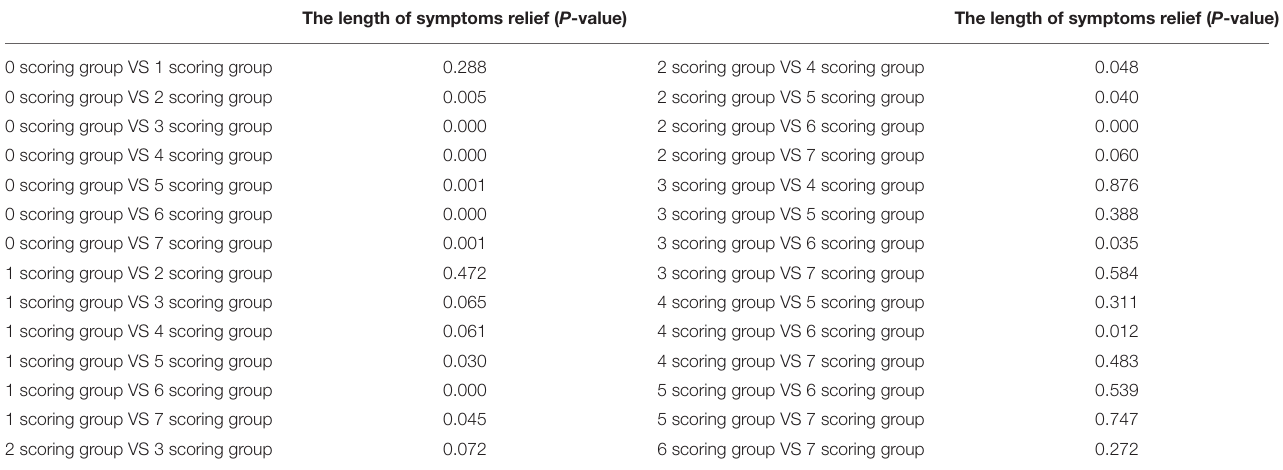
TABLE 11 | The comparison of scoring groups over the length of symptoms relief. The length of symptoms relief ( P -value) The length of symptoms relief ( P